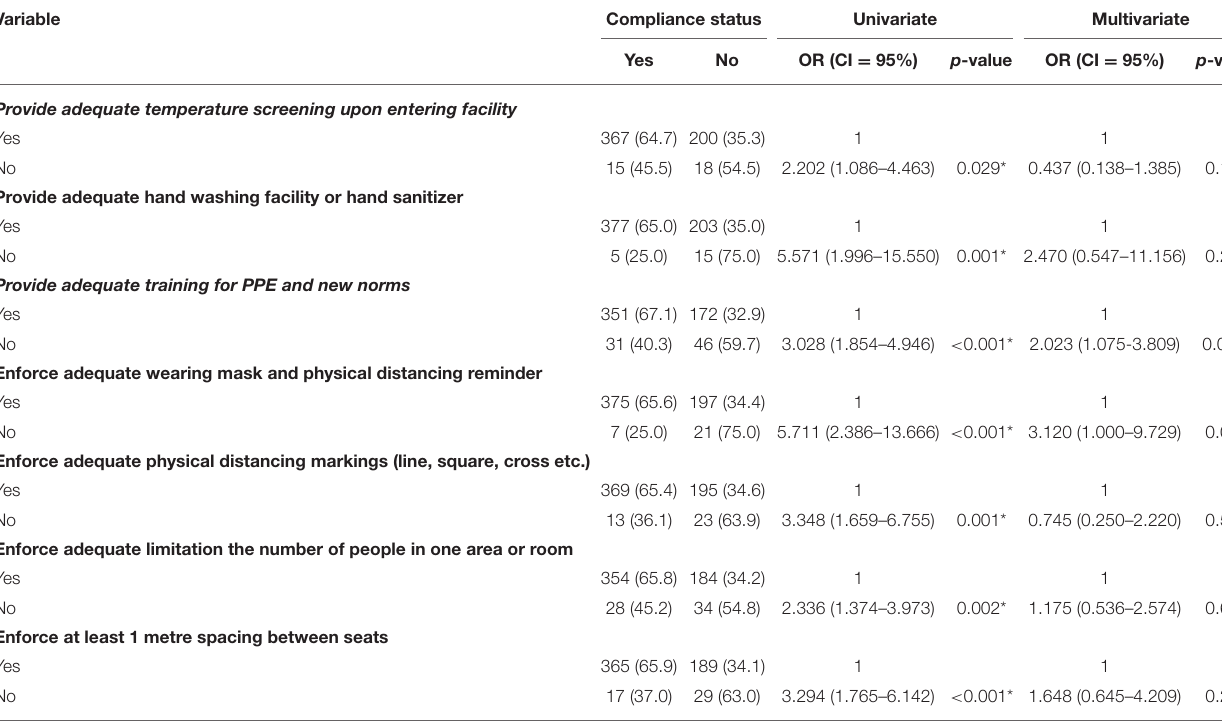
TABLE 4 | Organizational support provided by management in healthcare facilities.